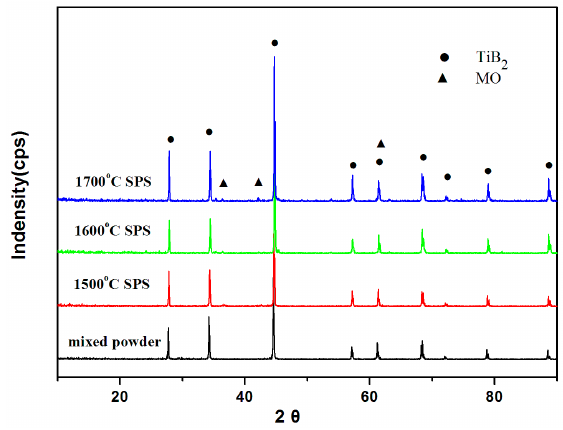
Figure 3. XRD patterns of the mixed powder and TiB 2 -5 wt. % HEA ceramics sintered at 1500 °C, 1600 °C, and 1700 °C by SPS.